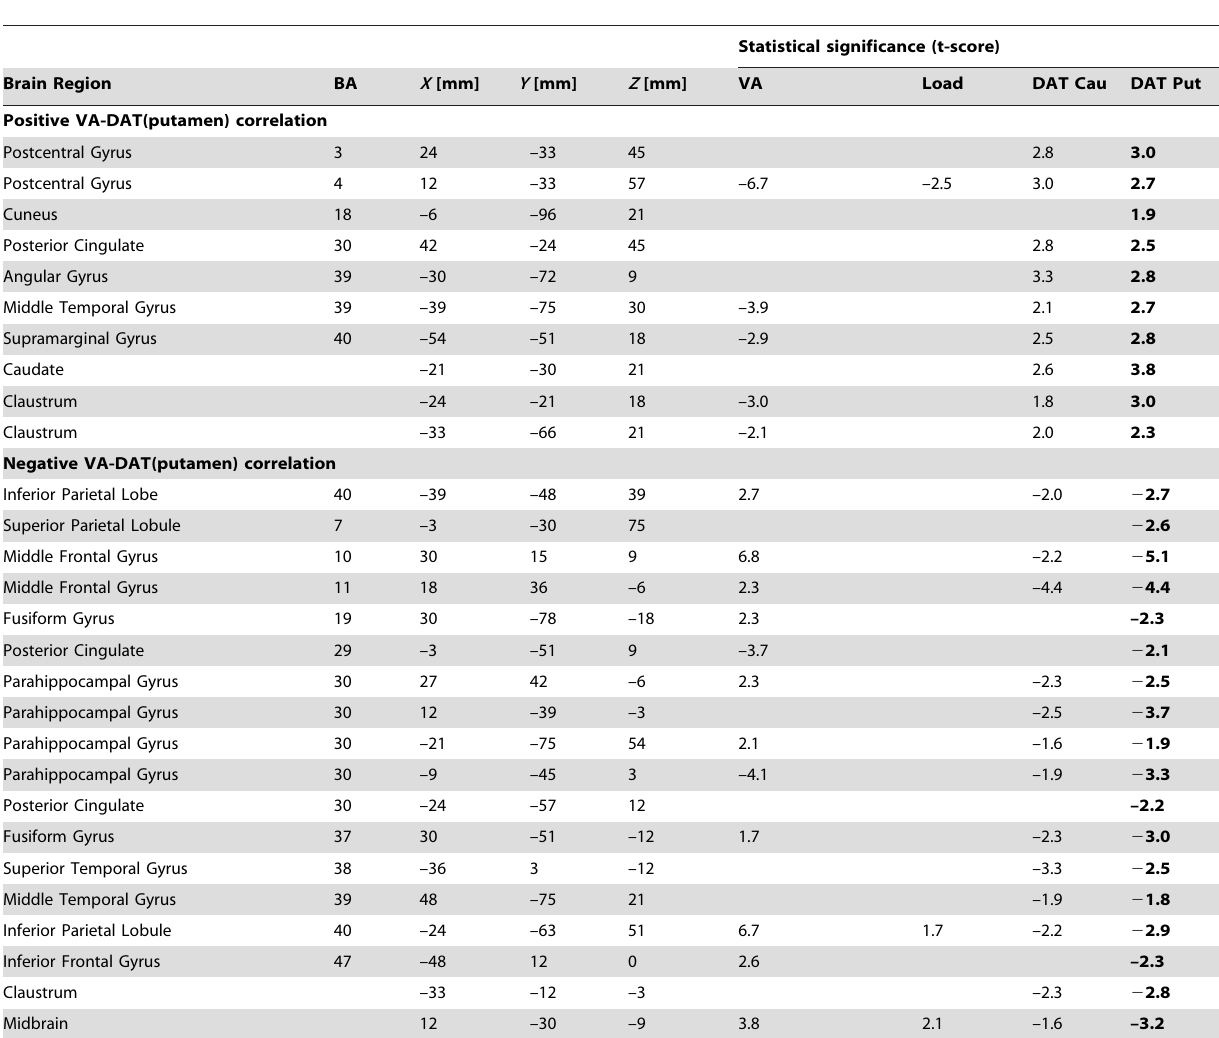
Table 4. Average statistical significance in regions-of-interest exhibiting correlations between BOLD-fMRI signals and DA transporters in